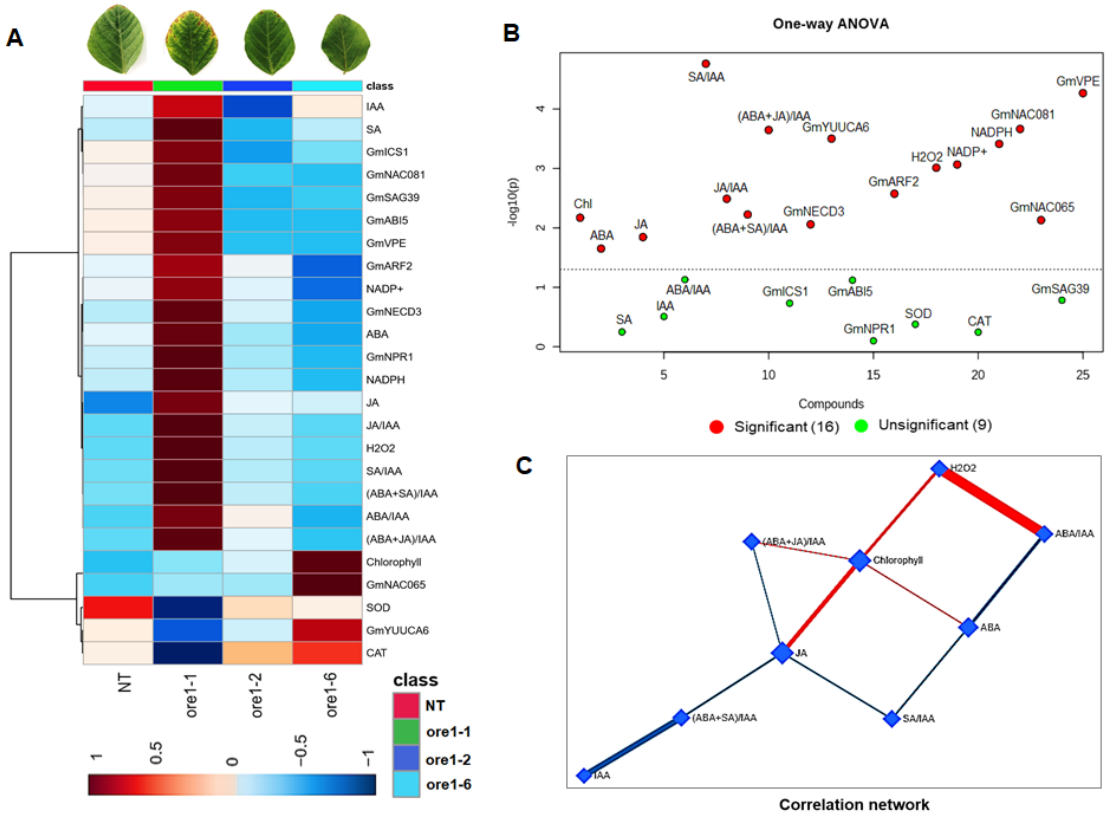
Figure 6. Identification of the regulator factors of leaf senescence in Atore1 -expressing soybeans. ( A ) Heatmap comparing the changes of the identified chlorophyll, hormones, ROS, and redox levels in the leaves of wild-type (NT) and transgenic plants. The normalization procedure consisted of mean row-centering with color scales. Clusters were generated by hierarchical clustering in a heatmap visualization, considering the expression value of each parameter and genes in the 25 putative tar- gets of the NT and ore1-1, ore1-2, and ore1-6 plants. Boxes indicated two expression trends: the